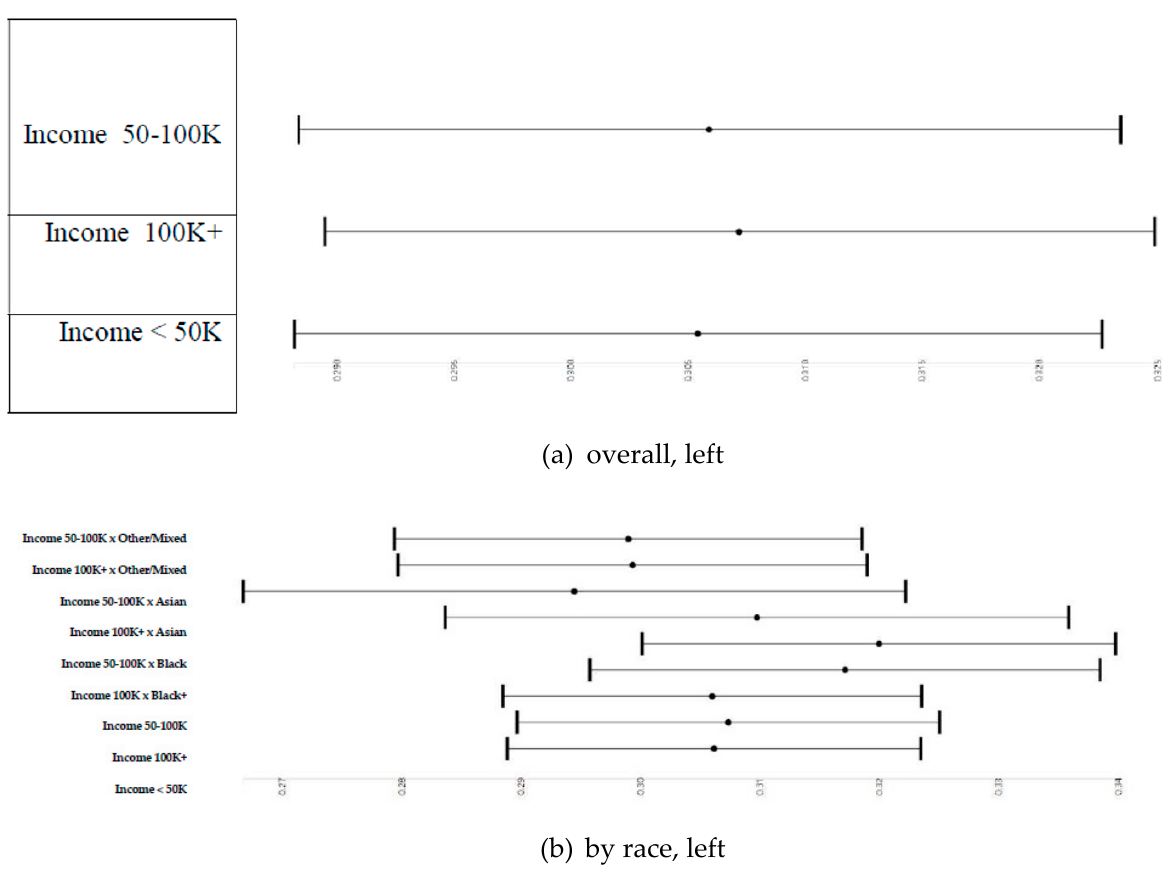
Figure 4. Association between household income and left cerebellum cortex fractional anisotropy overall and by race.